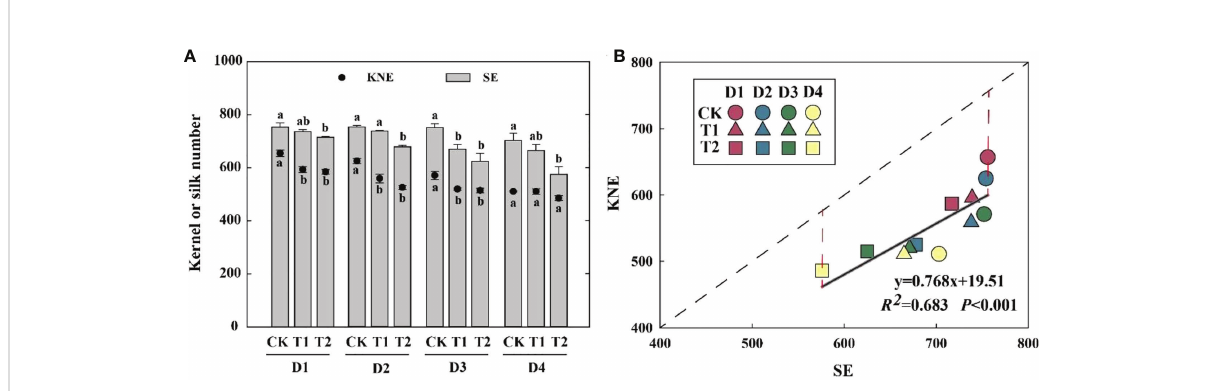
FIGURE 3 Effects of EC and PD on KNE and SE in summer maize in 2021 (A) . Different lowercase letters indicate signi fi cant differences between EC treatments at each plant density. Correlation between SE and KNE under EC and PD in 2021 ( n = 12 ) (B) . Solid lines indicate linear regression, and dashed lines indicate 1:1. R 2 indicates the coef fi cient of determination. R 2 > 0.4 and P < 0.05 indicate a signi fi cant relationship. EC, plant growth regulator; PD, plant density; D1, D2, D3, and D4 indicated plant density at 4.5, 6.0, 7.5, and 9.0 plants m − 2 , respectively; CK, T1, and T2